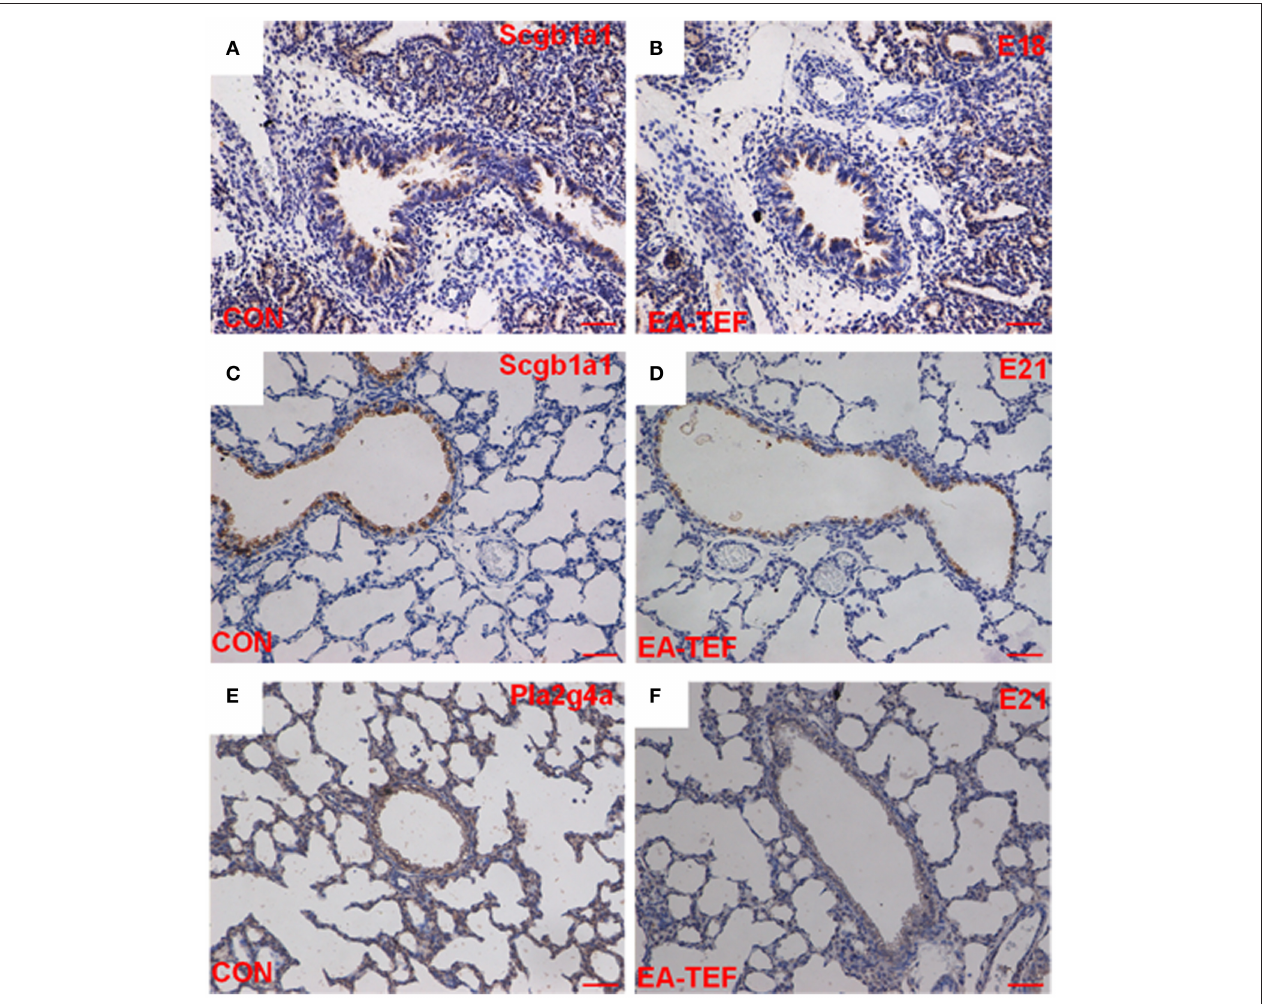
FIGURE 5 | Histological localization and quantification of Scgb1a1 and Pla2 protein in fetal lungs. (A–D) Representative photomicrographs of IHC- staining for Scgb1a1 in sections of lung tissue from control (A,C) and EA-TEF (B,D) embryos at E18 (upper panel) and E21 (lower panel). (Original magnification × 200, scale bar = 50 µ m). Scgb1a1 was primarily expressed in bronchial epithelial cells. At E21, Scgb1a1 staining intensity decreased in EA lungs compared with age-matched controls. (E,F) Representative IHC staining of Pla2g4a in the lung tissue sections from Control (E) and EA-TEF (F) embryos at E21. No changes were found in the expression and localization pattern of